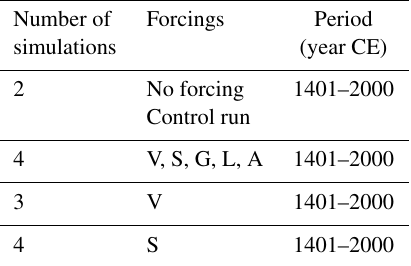
Table 1. All-forcing and single-forcing HADCM3 simulations and control runs used in this study (“V” stands for volcanic, “S” stands for solar, “G” greenhouse gases, “L” stands for land use, and “A” stands for tropospheric